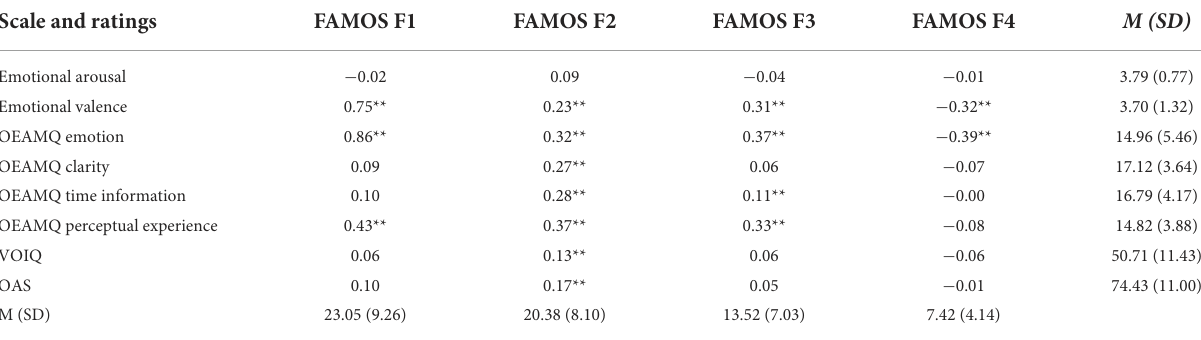
TABLE 2 The correlation coefficient between each